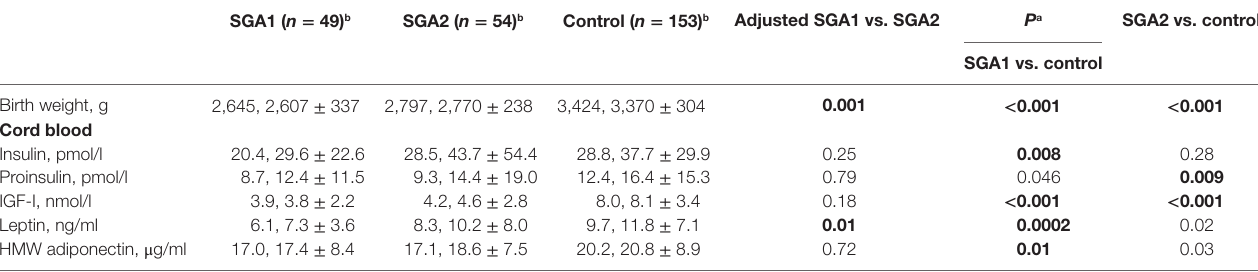
TaBle 4 | Birth weight and metabolic health biomarkers in cord blood comparing SGA infants with low (SGA1) or normal (SGA2) maternal circulating PlGF concentrations to control infants.